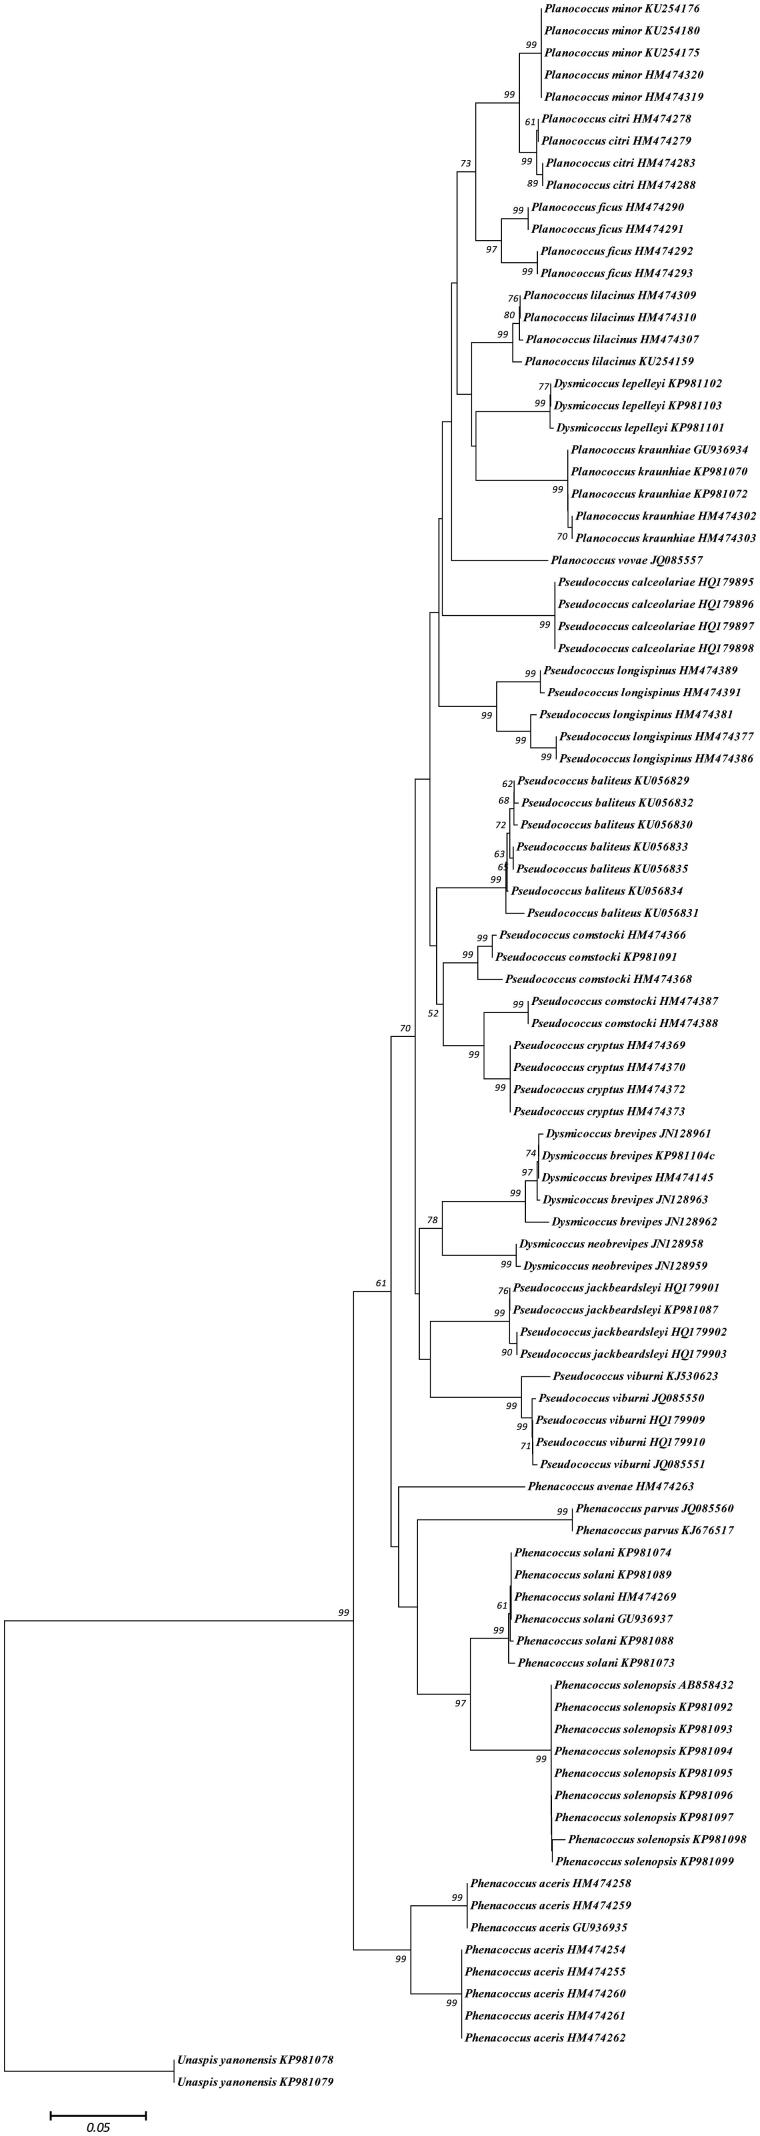
The Neighbour-joining tree for 21 species of Pseudococcidae based on COI sequences. Note: The numbers at the nodes indicate the bootstrap values, and only values above 50% are given. Scale bar indicates the genetic distance.